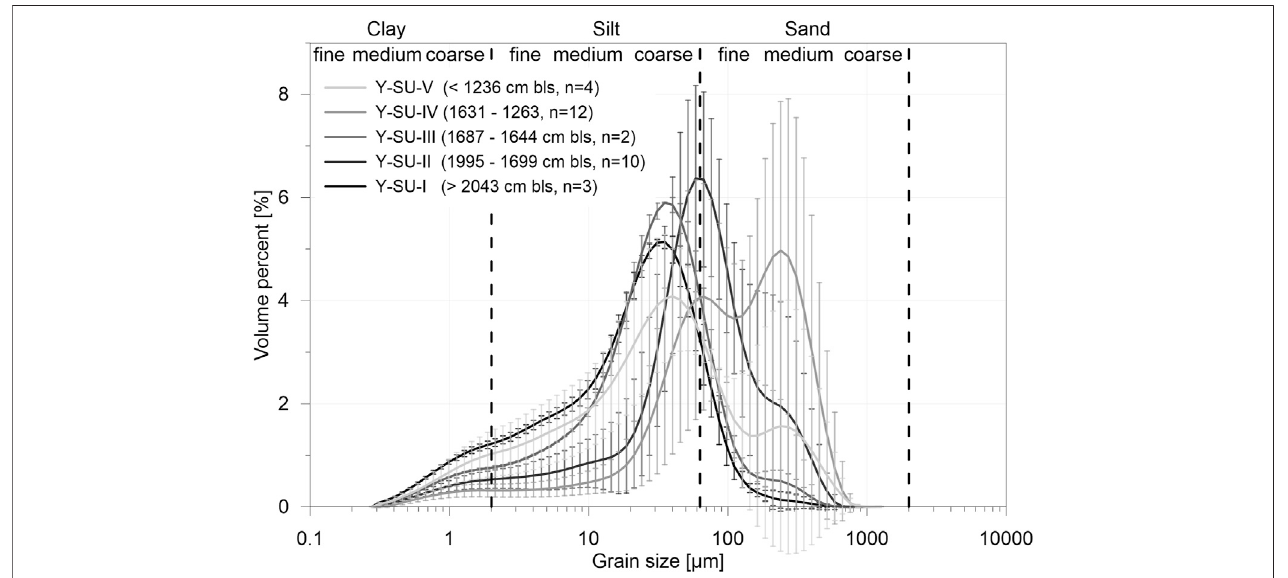
FIGURE 6 | Mean grain-size distributions for each sediment unit of the Yedoma lake core YU-L15 (see Figure 7 ). The error bars are indicating the standard deviations of individual measured grain sizes.